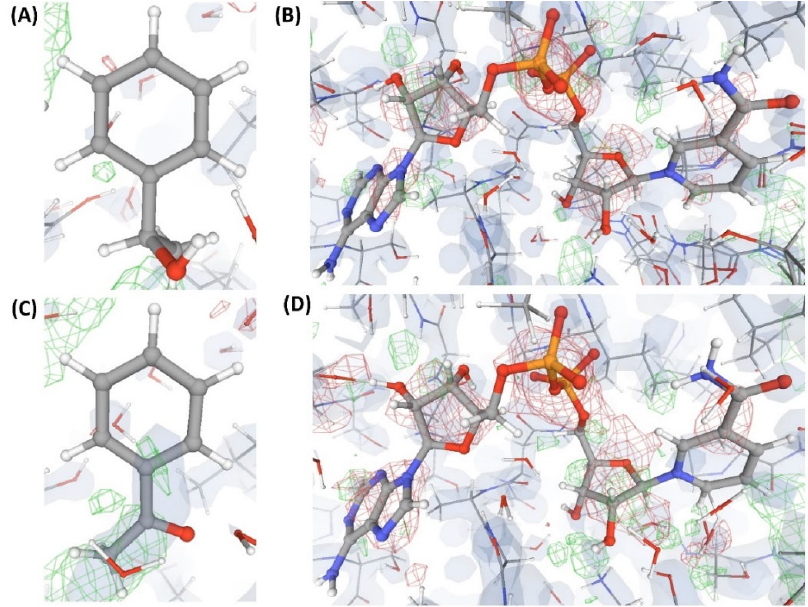
Figure 7. Electron density maps around the ligands (substrate and co ‐ substrate) bound to the structures (C7 and C8) discussed in case study ‐ 2. ( A ) L’” in C7 (1.54 Å). ( B ) L7 in C7 (1.54 Å). ( C ) L” in C8 (1.78 Å). ( D ) L5 in C8 (1.78 Å). For details on graphical representation styles and color codes of density maps, kindly refer to the legend of Figure 4.